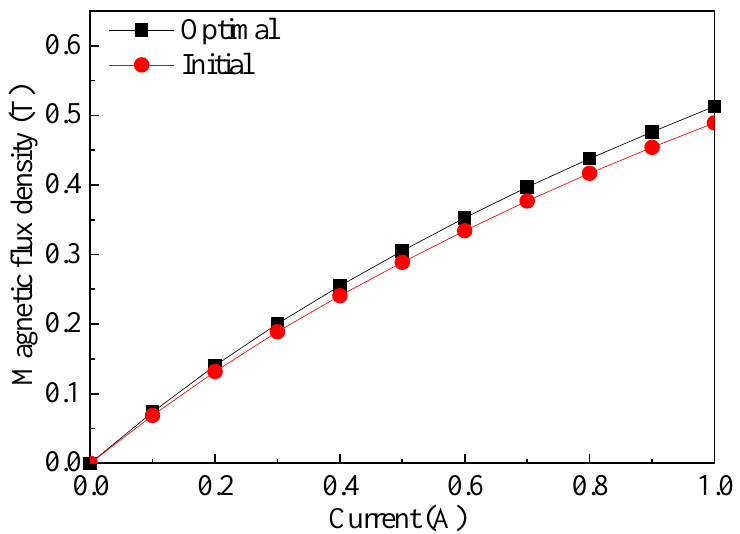
Figure 18. Average magnetic flux density with current for the initial and optimal radial MR valve.